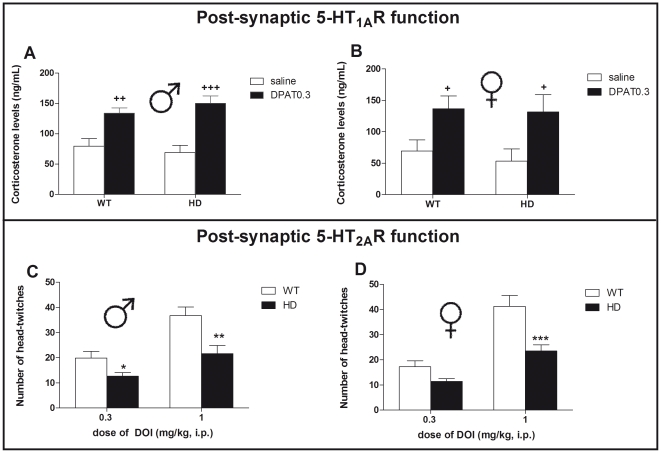
In vivo assessment of 5-HT1A and 5-HT2 post-synaptic receptor function using 8-OH-DPAT-induced change of corticosterone levels and DOI-induced head-twitches.Compared to paired-saline injected animals, administration of the 5-HT1A agonist 8-OH-DPAT (0.3 mg/kg, s.c.) significantly increased corticosterone levels in both (A) male and (B) female mice, regardless of the genotype. In the DOI-induced head-twitches experiment (bottom panel), there was a significant effect of genotype in both sexes. Indeed, the number of head-twitches following DOI (1 mg/kg) were decreased in (C) HD male and (D) HD female mice when compared to WT animals. Values represent means (± SEM) of n = 5–10 mice per group. Saline vs. DPAT0.3: (+) p<0.05, (++) p<0.01, (+++) p<0.001 WT vs. HD: (*) p<0.05, (**) p<0.01, (***) p<0.001.